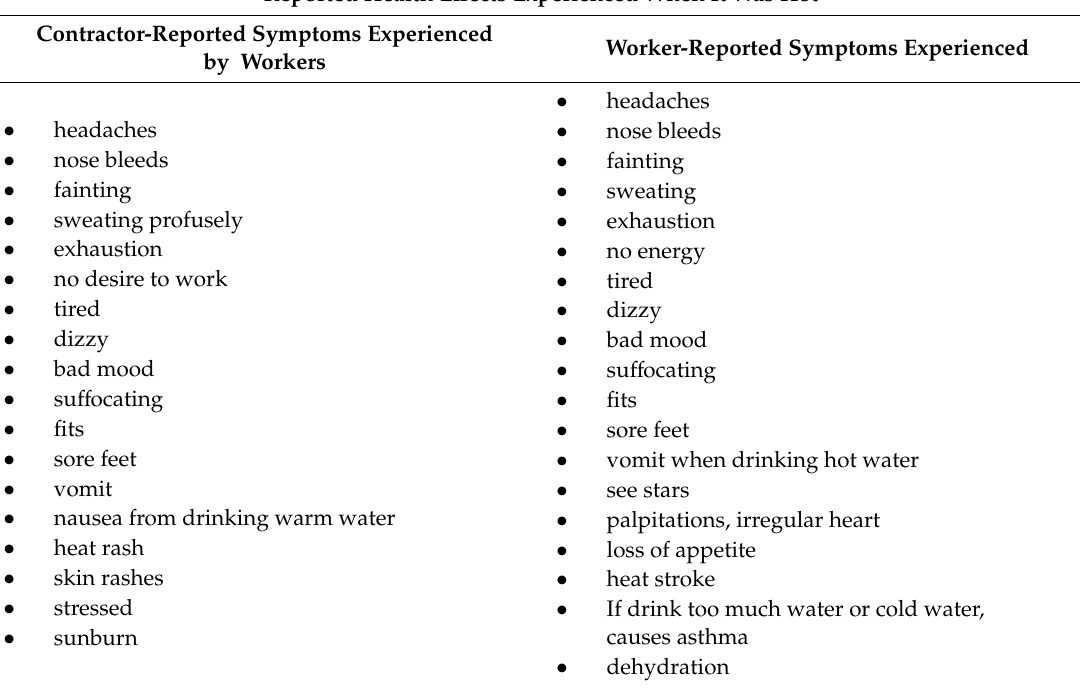
Table 2. Health e ff ects reportedly experienced by workers when it was